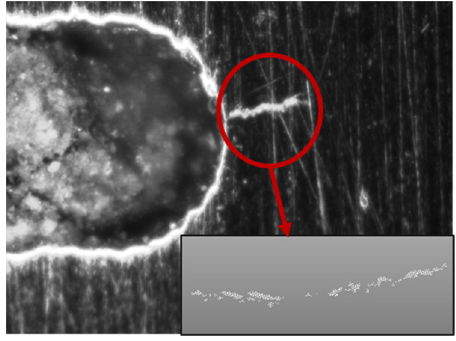
Figure 8. Extracted point cloud from the captured image.